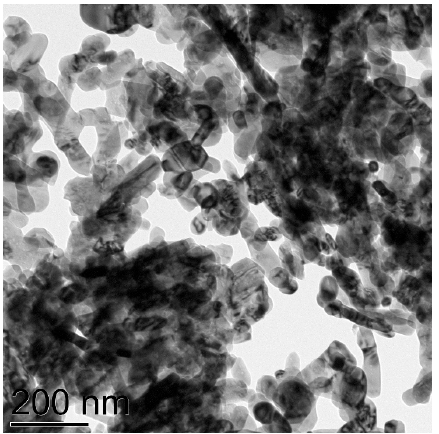
Figure 5. TEM images of Cu 2 O NPs of the average particles size 68 nm (two views, ( a , b )) and 87 nm (two views, ( c , d )). At last, the investigation of the commercial CuO nanoparticles with claimed size “<50 nm” revealed that their average size is in fact ca. 65 nm (Figure 6), they are well isolated, possess stretched shape, and electronogram verified the composition CuO with monoclinic C2/c lattice (Figure S7).